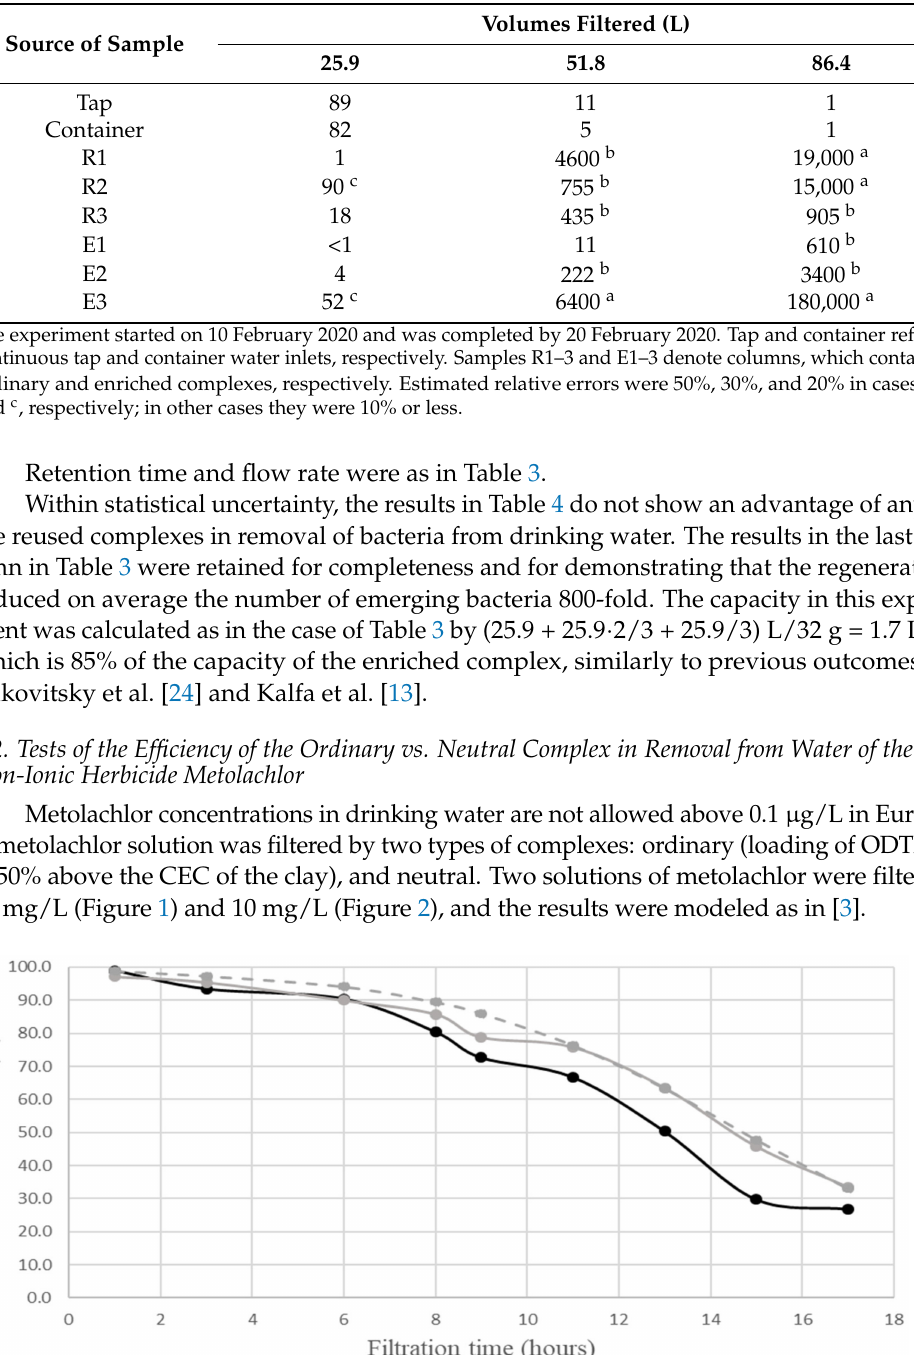
Table 4. Removal of TBC by ODTMA granules after first regeneration (CFU/L).